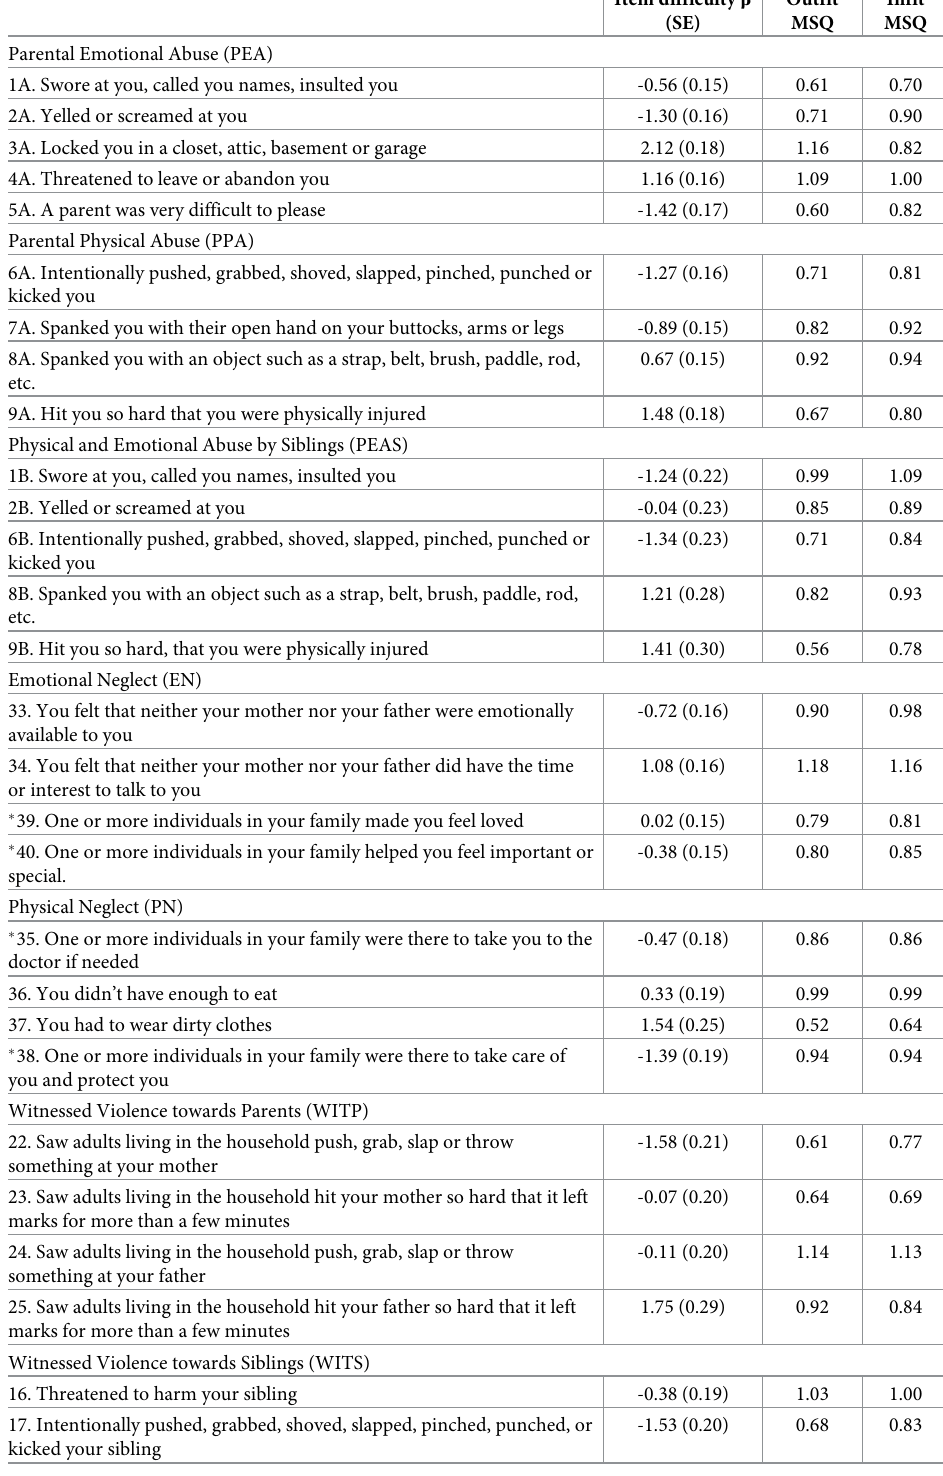
Table 2. Item fit statistics for all KERF-40+